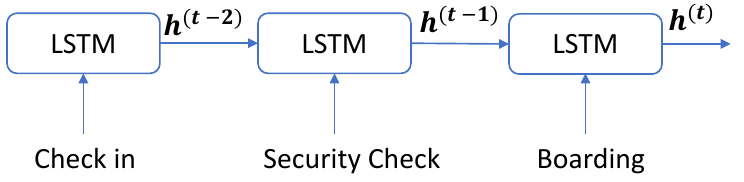
Figure 5. Unfolded LSTM network for the prefix of e 5 , the activities are in vector